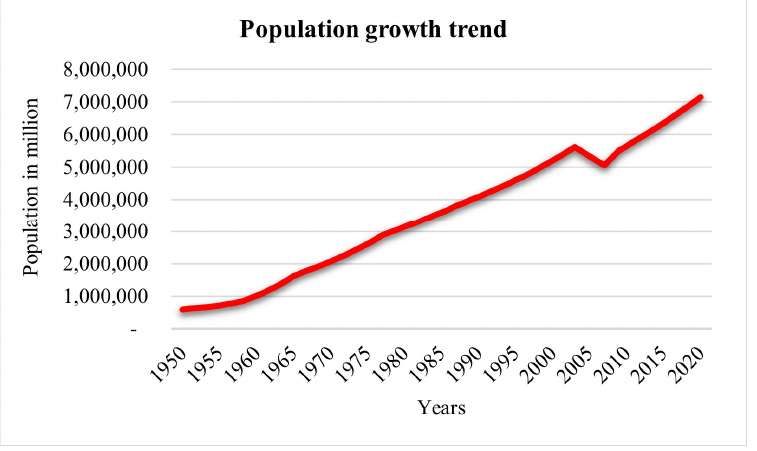
Figure 2. Baghdad population growth trend from 1950 to 2020.